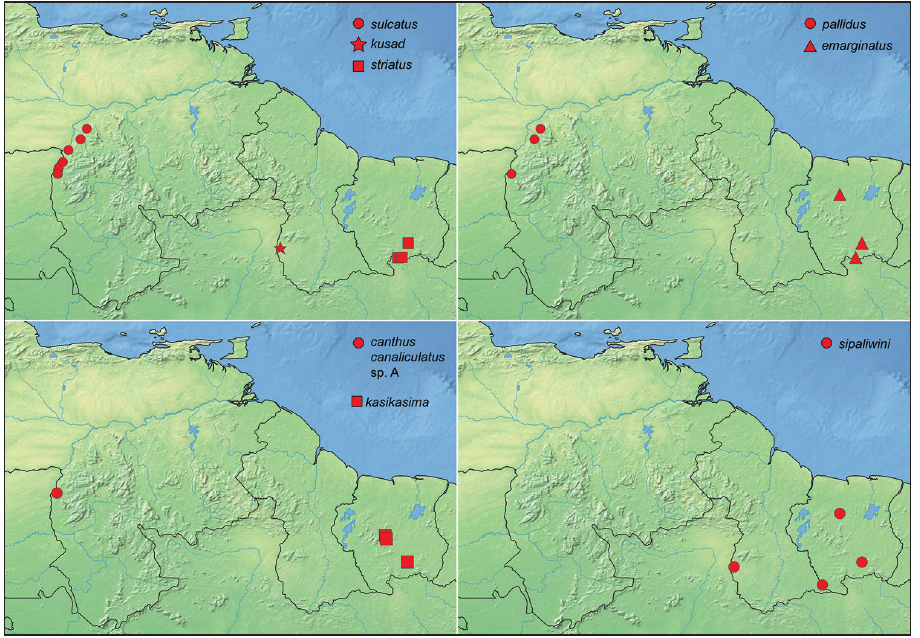
Figure 15. Distribution of Tobochares